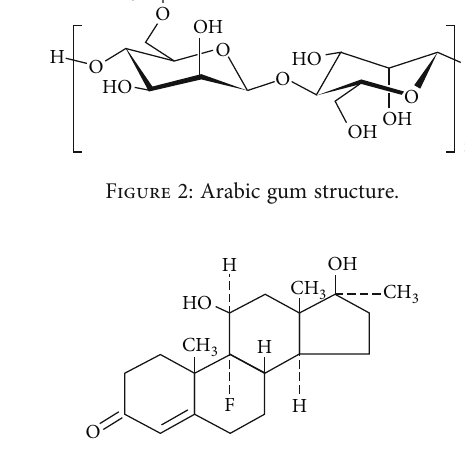
Figure 3: Tragacanth gum